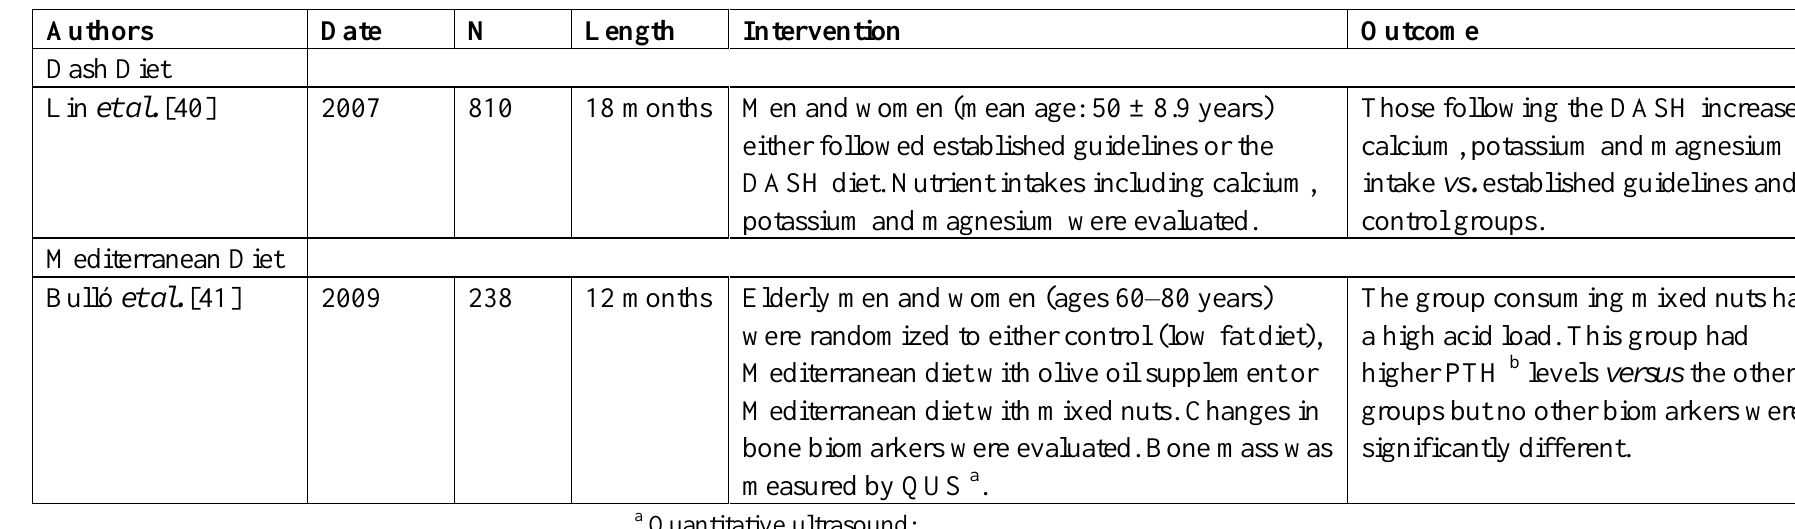
Table 4. Portfolio diets on bone